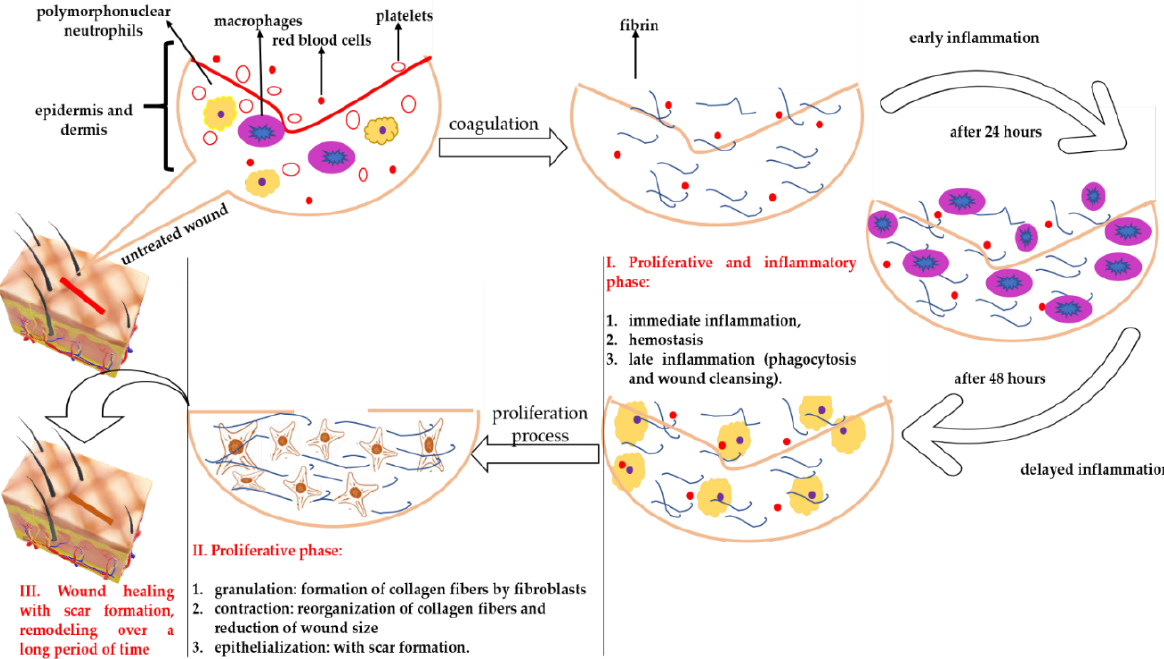
Figure 1. Stages of wound healing and the implications of fibroblasts in this process.